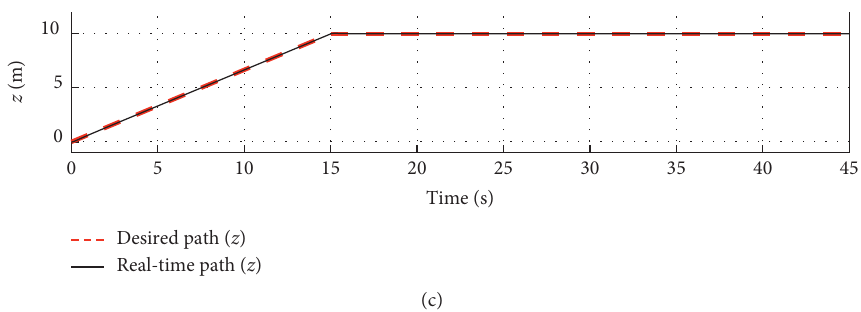
Figure 12: Curve of changing position.